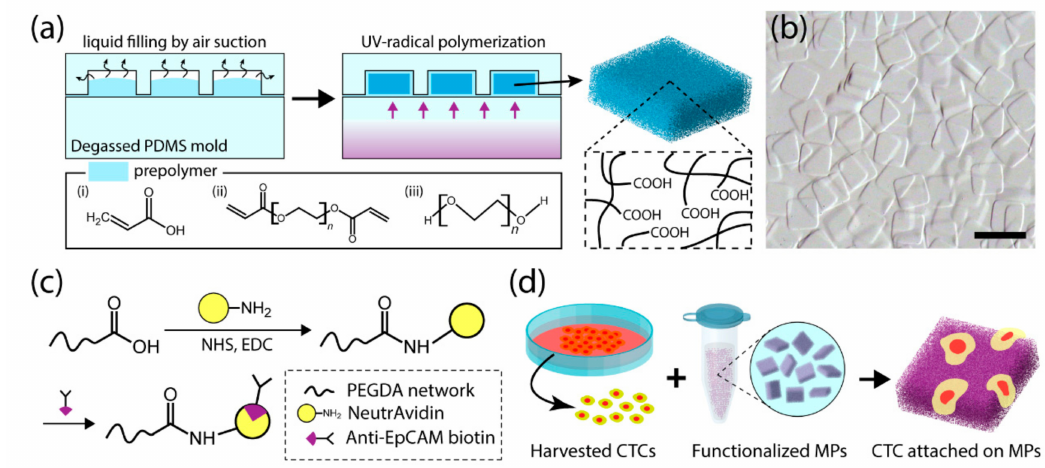
Figure 1. Schematic view of particle synthesis and cell test: ( a ) Particle synthesis process called degassed mold lithography (DML). Through UV-induced radical polymerization with the prepolymers (i) acrylic acid, (ii) polyethylene glycol diacrylate (PEGDA), and (iii) polyethylene glycol (PEG), hydrogel microparticles containing carboxyl groups are synthesized. ( b ) Bright-field image of polymerized hydrogel microparticle. Scale bar is 200 µ m. ( c ) Carbodiimide cross-link chemistry is used to conjugate anti-EpCAM to carboxyl groups. Carboxyl groups in the particles react to primary amines in NeutrAvidin with the help of N-hydroxysuccinimide (NHS) and N-(3-dimethylaminopropyl)- N (cid:48) -ethylcarbodiimide hydrochloride (EDC). Using the interaction between avidin protein and